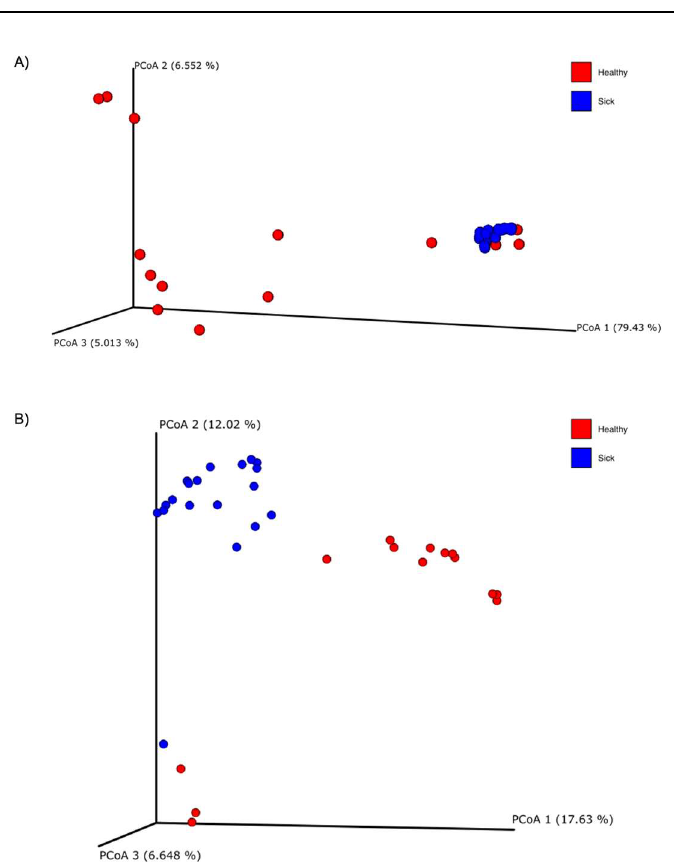
Figure 3. Principal coordinate analysis (PCoA) plots of the ( A ) weighted and ( B ) unweighted UniFrac beta diversity of the blood microbiome of healthy (red dots) and sick (blue dots) dogs.